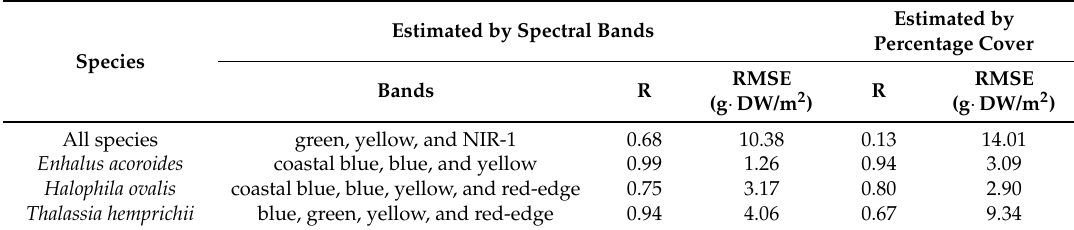
Figure 5. Plot of observed vs. estimated seagrass above-ground biomass (g·DW/m 2 ) using the multiple linear regression model for ( a ) all species; ( b ) Enhalus acoroides ; ( c ) Halophila ovalis ; and ( d ) Thalassia hemprichii . The observed above-ground biomass values are based on the field data gathered from 16 to 18 February 2014 in Paklok Bay. Table 8. The performance of models (R and Root Mean Square Error) for the above-ground biomass estimates of all species and Enhalus acoroides , Halophila ovalis , and Thalassia hemprichii species, where above-ground biomass was estimated by spectral bands and percentage cover.